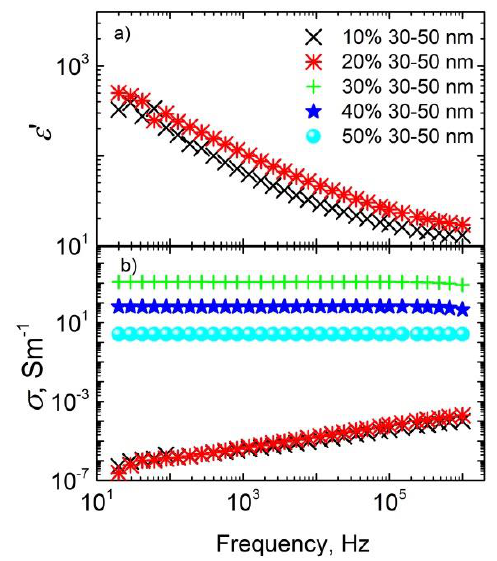
Figure 2. Room-temperature dielectric permittivity ( a ) and electrical conductivity ( b ) of phosphate ceramics with Ag inclusions (30–50 nm nanoparticles) plotted as a function of frequency.